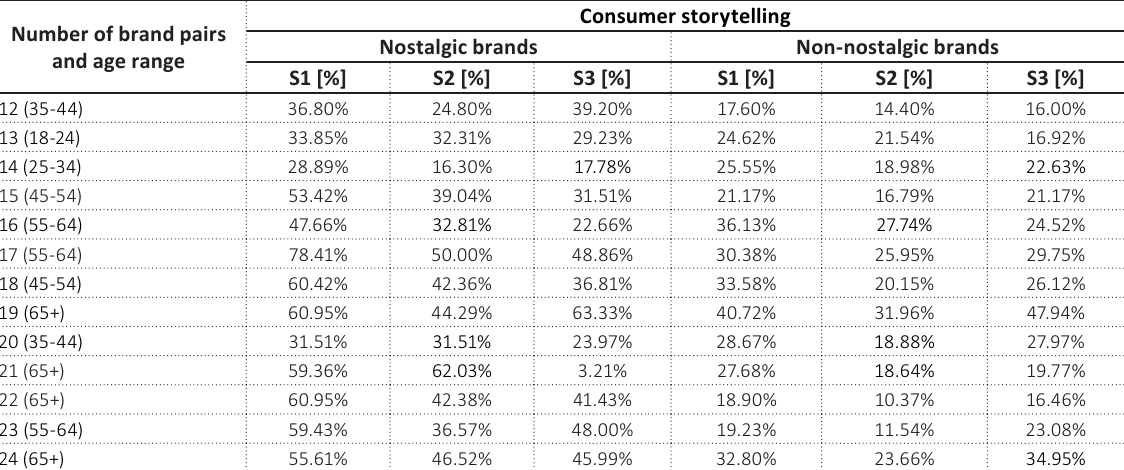
Source: Own study.